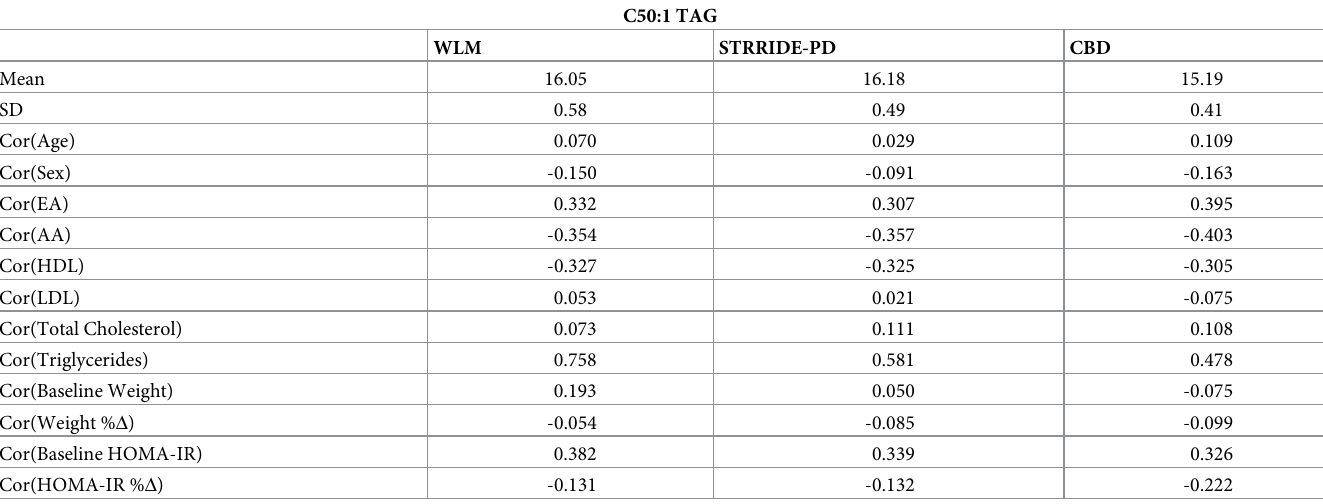
HOMA-IR (S2 Table). Table 2 compares the effect size estimates of the univariate model with the full model for the top 10 metabolites, demonstrating significance and consistency of mag- nitude and directionality of effect. Table 3 shows summary statistics and correlations with phe- notypes for C50:1 TAG as an example of the metabolite data in this study. Comparison of univariate model individual metabolite analysis (the primary analysis) to the full model conditional analyses where traditional clinical measures of age, sex, race, base- line clinical triglycerides, and percent change in weight over the follow-up time period were added to the model. The lack of major changes in effect sizes between the two models indicates the individual metabolites identified in the primary analysis provide additional clinical value over the traditional clinical measures. “Metabolite” is the common name for the metabolite. “N” is the number of individuals in the meta-analysis model. “Pvalue” is the random-effects p- value for the model. “Pvalue_FDR” is the primary p-value after FDR multi-test correction. “Beta” is the random-effects effect size estimate for the inverse-variance weighted random Table 3. Example metabolite and phenotype correlations for C50:1